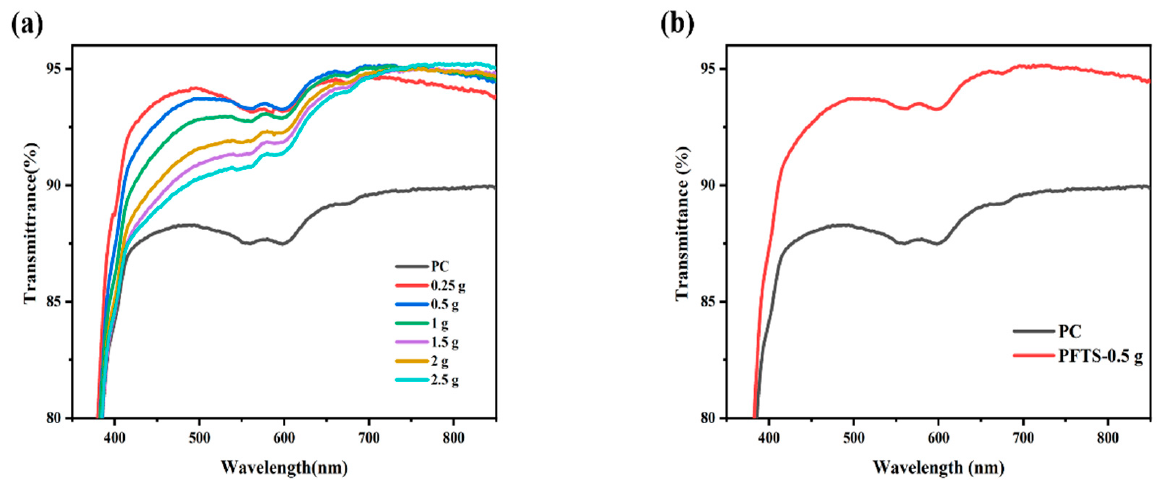
Figure 1. Transmittance spectra of the ZrO 2 -SiO 2 hybrid coatings ( a ) different contents of ZrO 2 sol , ( b ) 0.5 g ZrO 2 -SiO 2 sample modified with 3.5 × 10 − 3 mol PFTS. Figure 1. Transmi tt ance spectra of the ZrO 2 -SiO 2 hybrid coatings ( a ) di ff erent contents of ZrO 2 sol , ( b ) 0.5 g ZrO 2 -SiO 2 sample modi fi ed with 3.5 × 10 − 3 mol PFTS. Table 1. Average and peak (400–800 nm) transmittance of bare and coated PC Table 1. Average and peak (400–800 nm) transmi tt ance of bare and coated PC substrate.